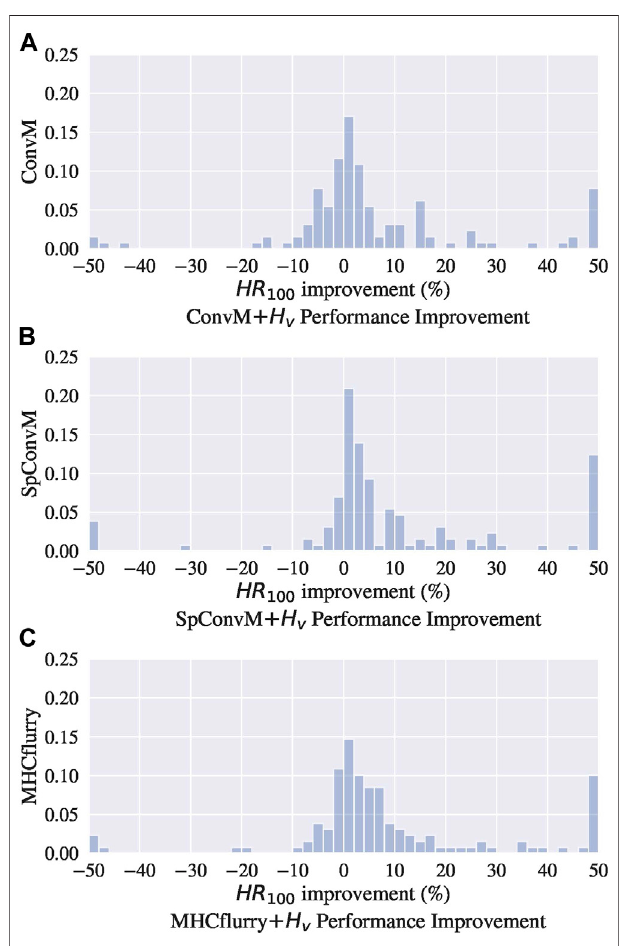
FIGURE 2 | Performance improvement compared with MHCflurry with MS among all